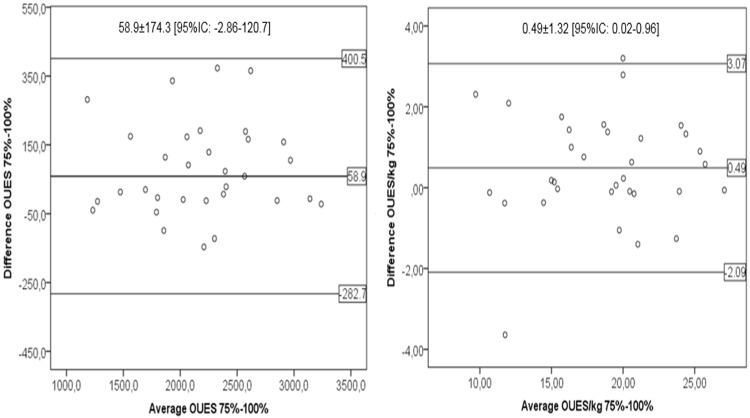
Bland-Altman plots of the relationship of OUES75% and OUES100%.Each dot corresponds to a subject. Horizontal lines represent the bias and the upper and lower limits of agreement.